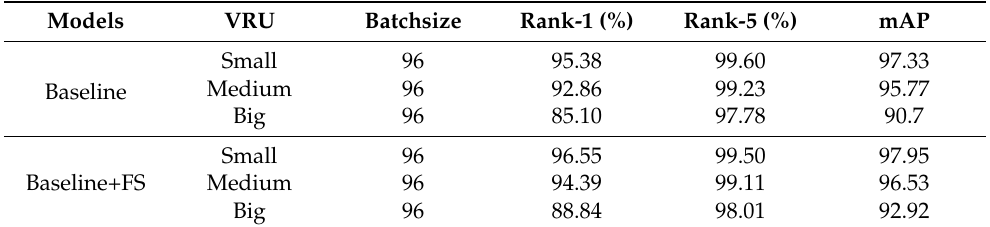
Table A7. Test results of the baseline model and the full-scale model with input batch 96 on the VRU dataset.